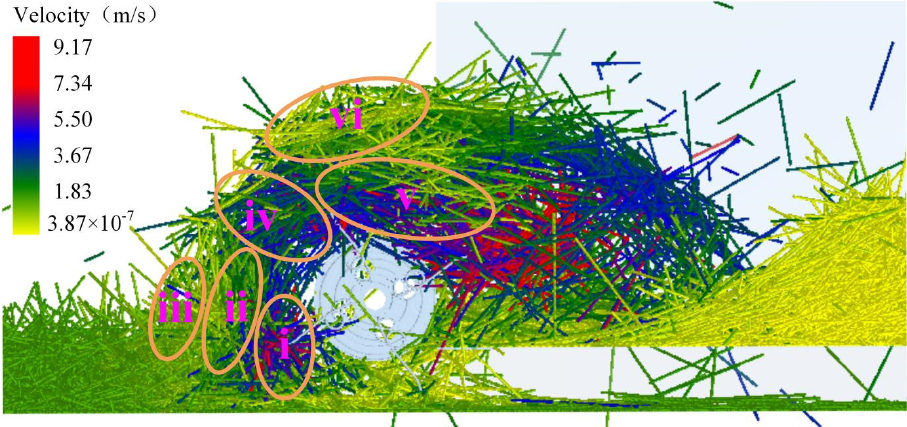
Figure 9. Analysis of straw movement area. 1. Picking area, 2. Towing area, 3. Extrusion area, 4. Pushing area, 5. Throwing area, 6. Detention area. We randomly select three stalks of length 270 mm on the top surface, middle layer and bottom layer of the straw pile, labeled as straw #1, straw #2 and straw #3. The average speed variation of the stalks is observed, as shown in Figure 10.